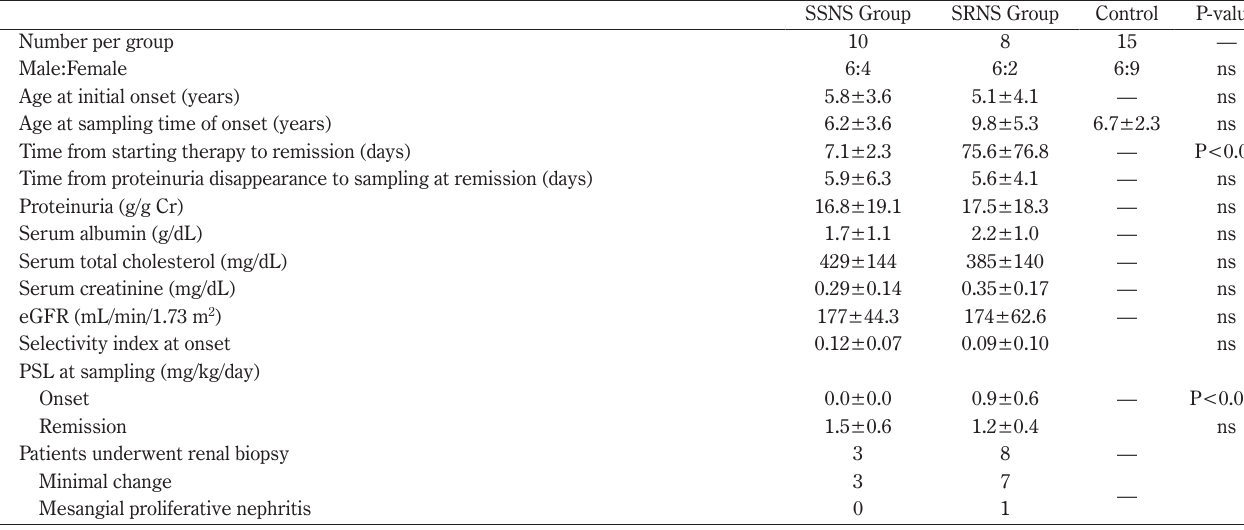
Table 1 Patients’